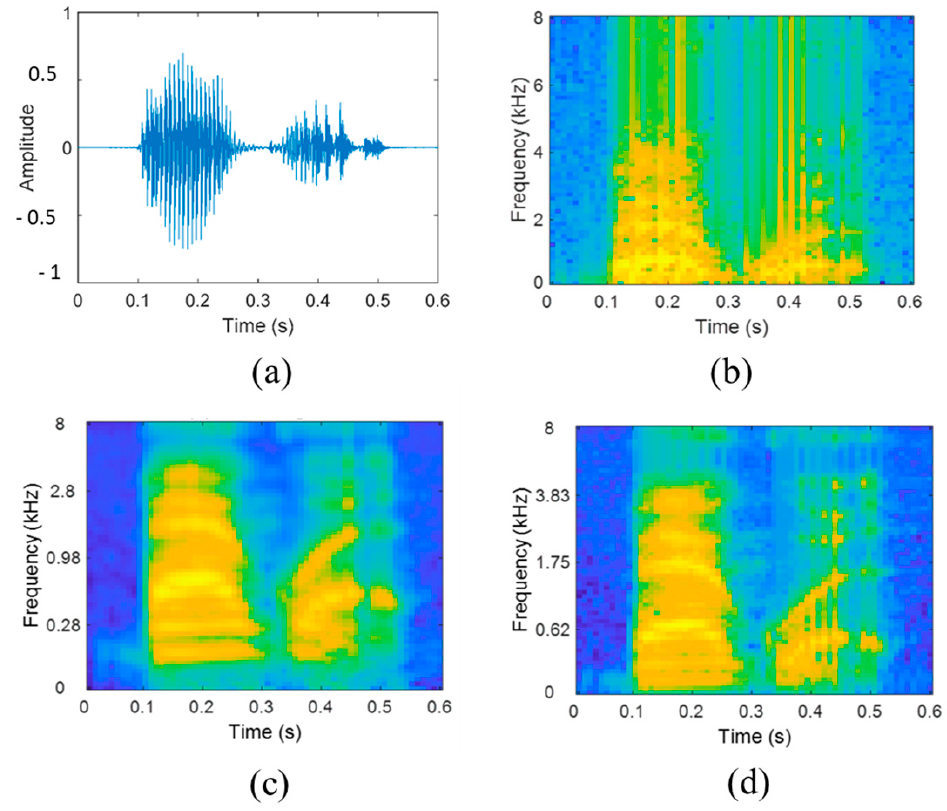
Figure 4. Acoustic image representation ( a ) acoustic input ( b ) spectrogram of acoustic input ( c ) coch-